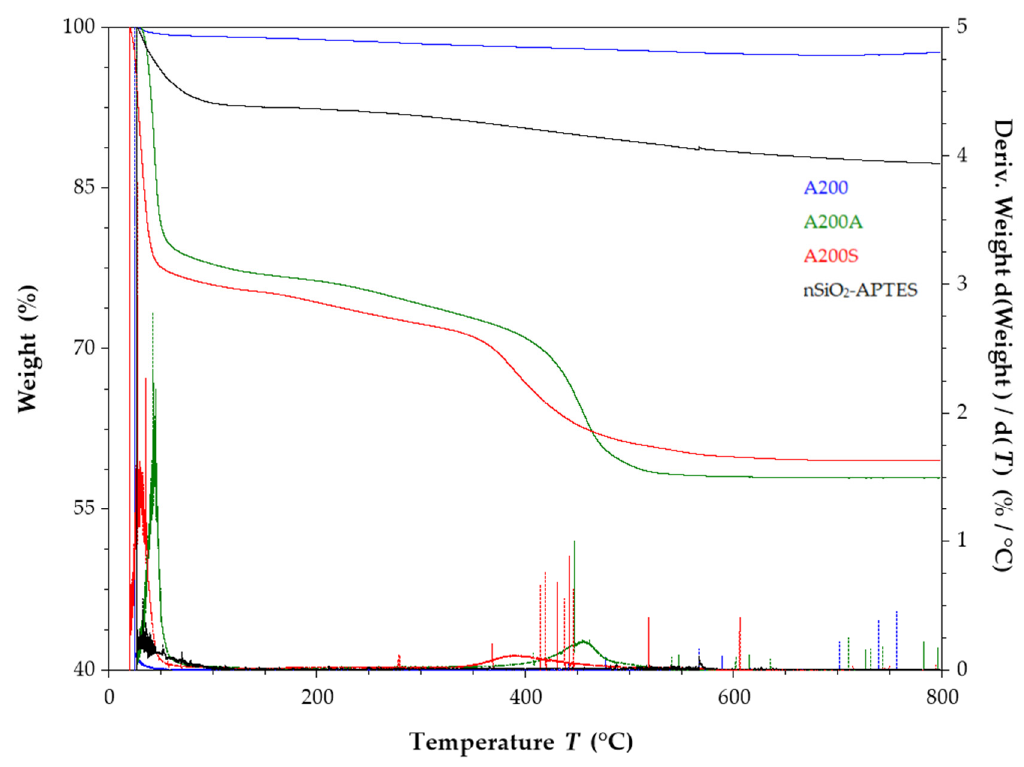
Figure 14. Thermograms of A200, A200A, A200S and nSiO 2 -APTES NPs (heating rate of 10 °C/min in a nitrogen atmosphere).